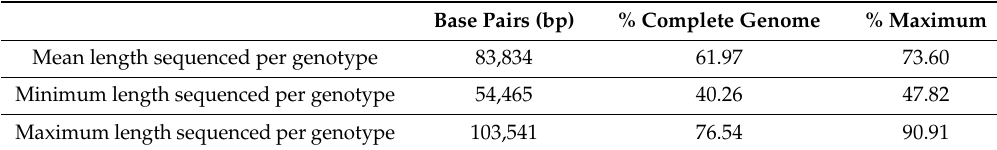
Table 2. Mapped length of Dactylis plastome sequenced.